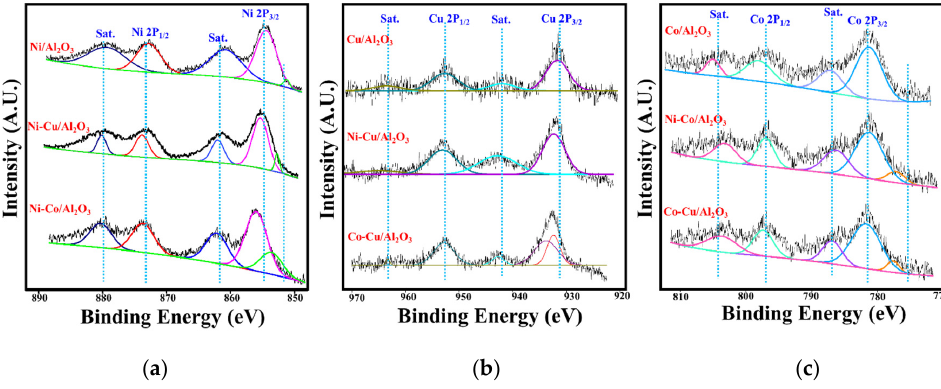
Figure 6. Deconvoluted XPS patterns ( a ). Ni 2p ( b ). Cu 2p ( c ). Co 2p of reduced monometallic and bimetallic